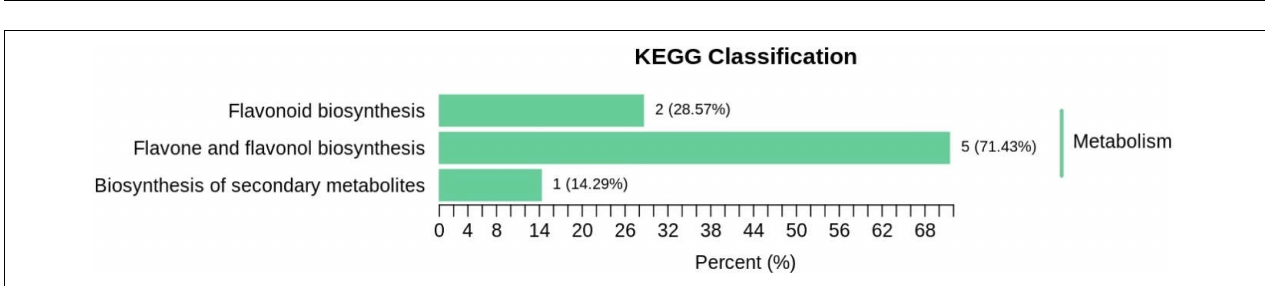
FIGURE 7 | Difference multiples of flavonoids in Qssg and Lc fruits variation diagram. (The abscissa is the difference multiple of differential metabolites, with 2 as the base pair, and the ordinate is the differential metabolite. Red and green represent up regulation and down regulation of differential metabolites, respectively).